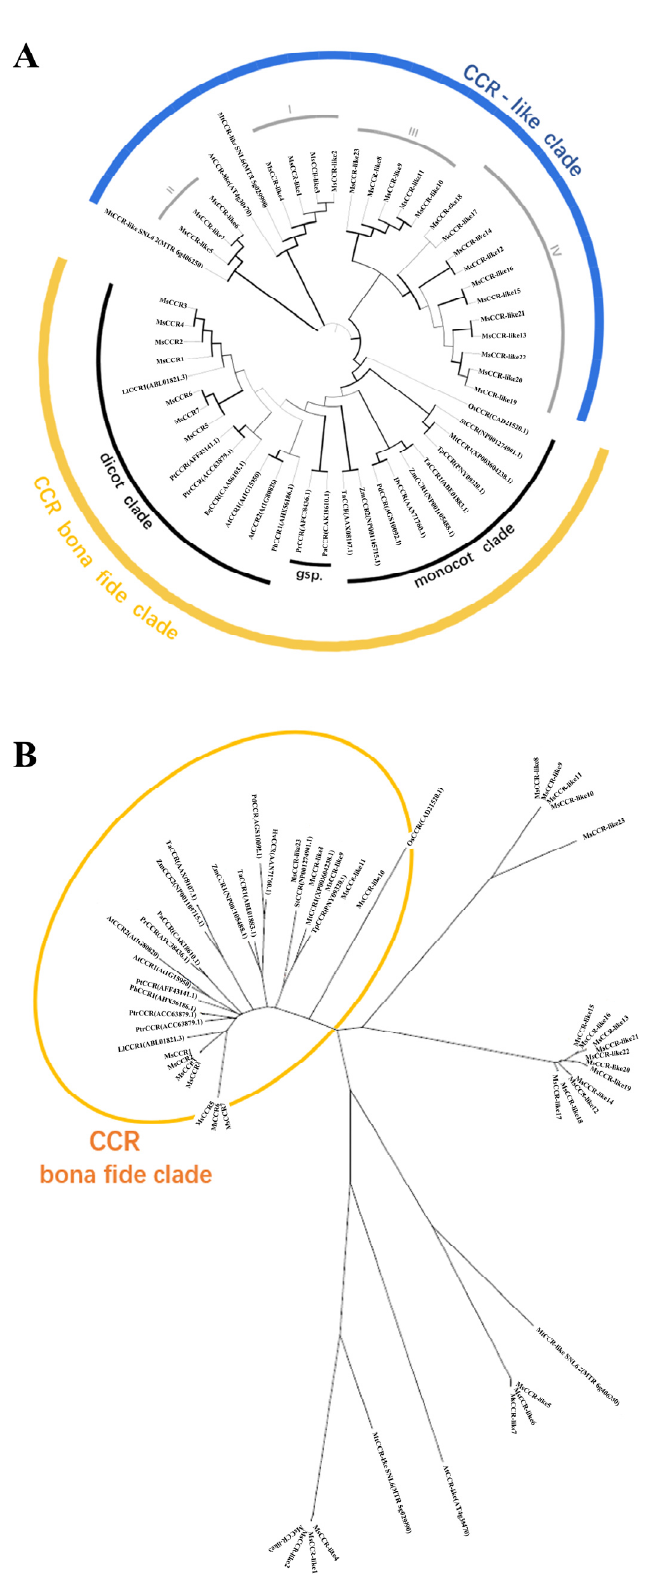
Figure 2. The phylogenetic analysis of CCR proteins across various plants. Traditional phylogenetic tree ( A ) and radiation tree ( B ) of 30 CCR protein sequences from M. sativa and 22 CCR protein sequences from other species. Protein sequences were constructed using MRGA-X software based on the neighbor-joining (NJ) method. The species name and the accession number of sequences used to construct the phylogenetic tree are listed in Table S3.